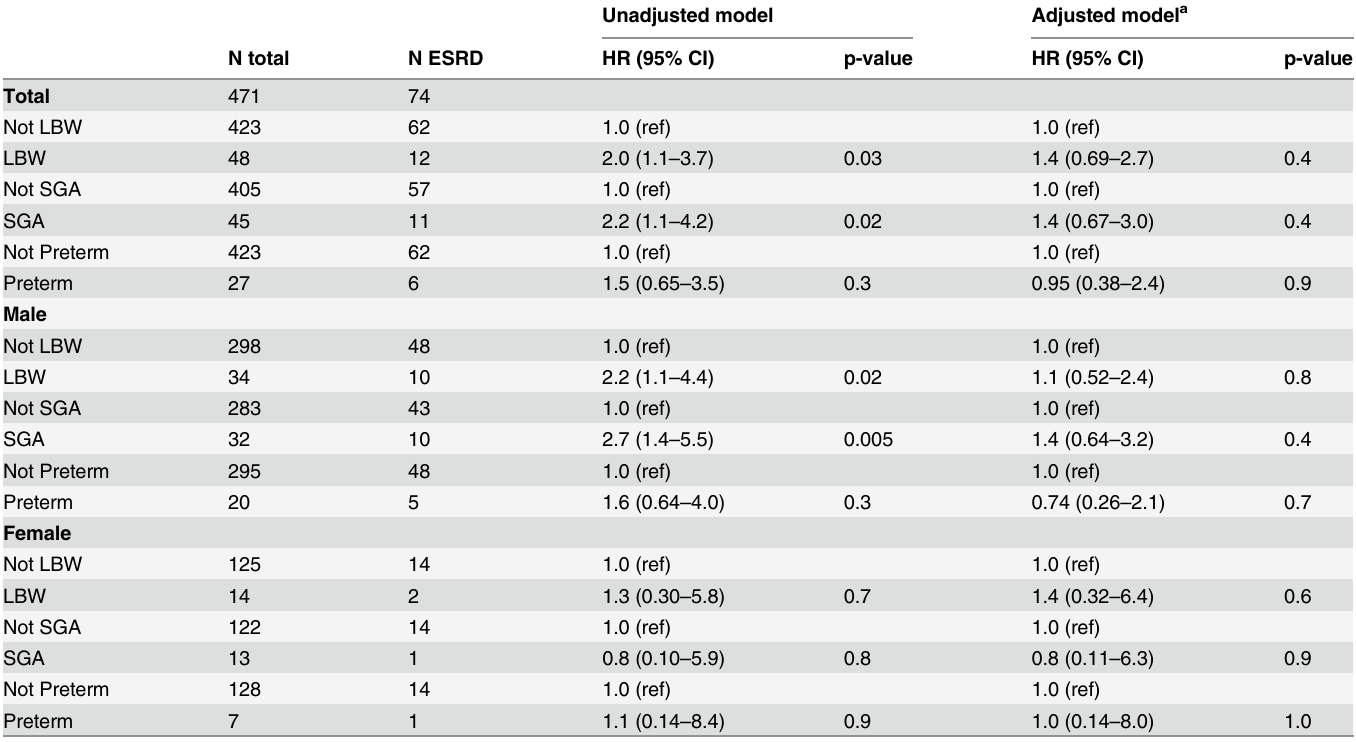
Table 2. Risk of ESRD according to whether the IgAN patients had LBW, SGA or preterm birth, separate analyses for male and female, Norway 1967 – 2013. Unadjusted model Adjusted model a